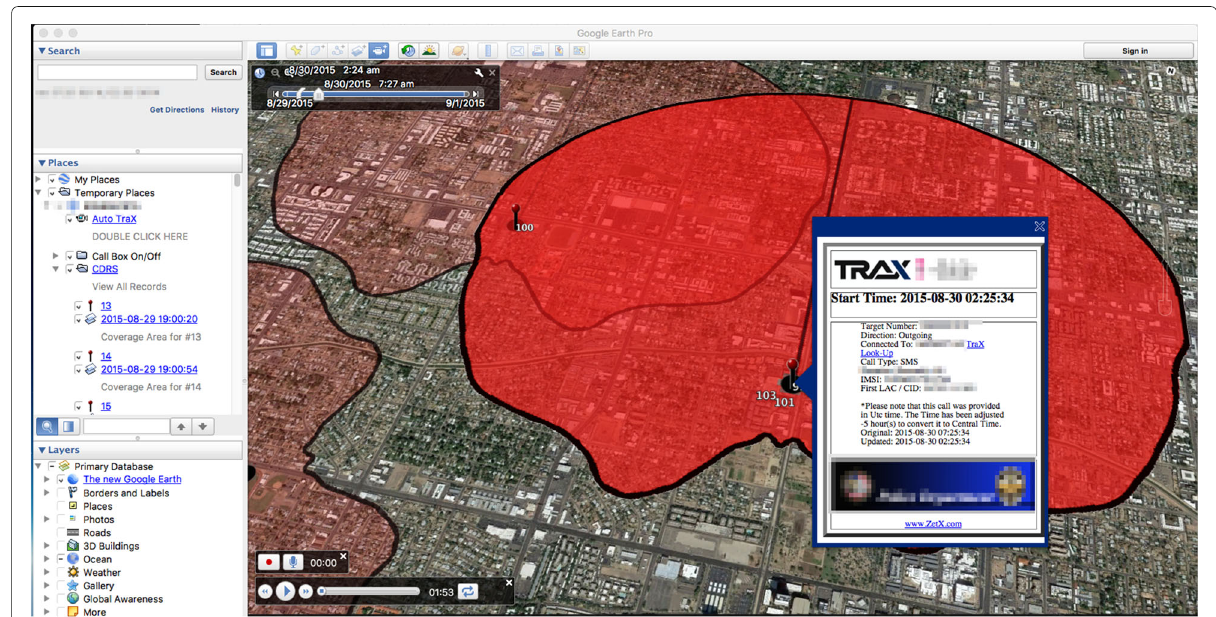
Fig. 4 A CDR for an LTE voice call. This is an original CDR from a non-real-time cellular network investigation so the MSISDN, IMSI, LAC, and CID are blurred to protect the anonymity of the target